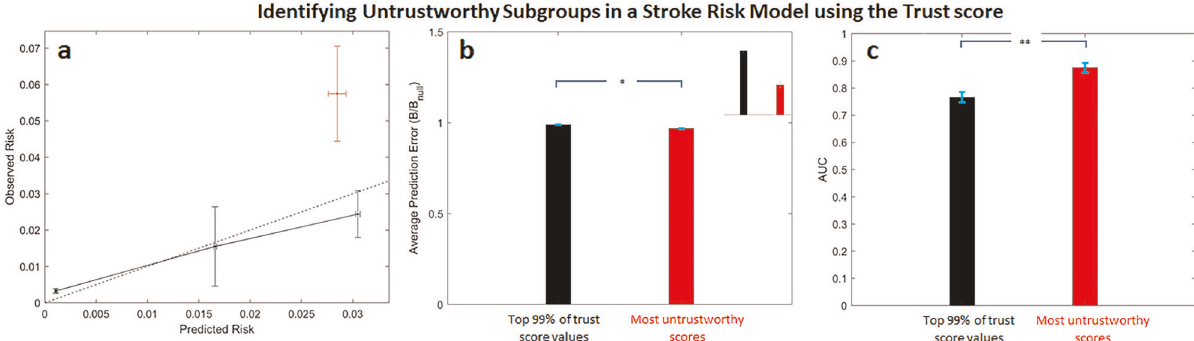
Fig. 6 Untrustworthy predictions in the Stroke risk model using the trust score. a Calibration curves, b normalized Brier scores (inset shows expanded region corresponding to 0 : 95 (cid:2) Brier = Brier null (cid:2) 1 : 0 ), and c AUCs for the most untrustworthy predictions (red) and those that fall * Þ within the bottom 99% U ð x values (black). * p < 0.05, ** p « 0.0001. Error bars are from 100 bootstrap splits and show one standard deviation ( a ) or one standard error of the mean ( b and c